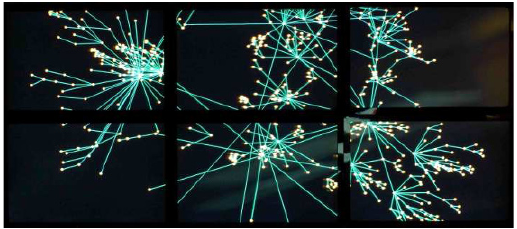
Figure 21. Compressing the depth by 6-1 eliminates the ghosting. Content from the “How Much Information” project, An- drew Prudhomme. Photo: Tom DeFanti. (Autostereo not turned